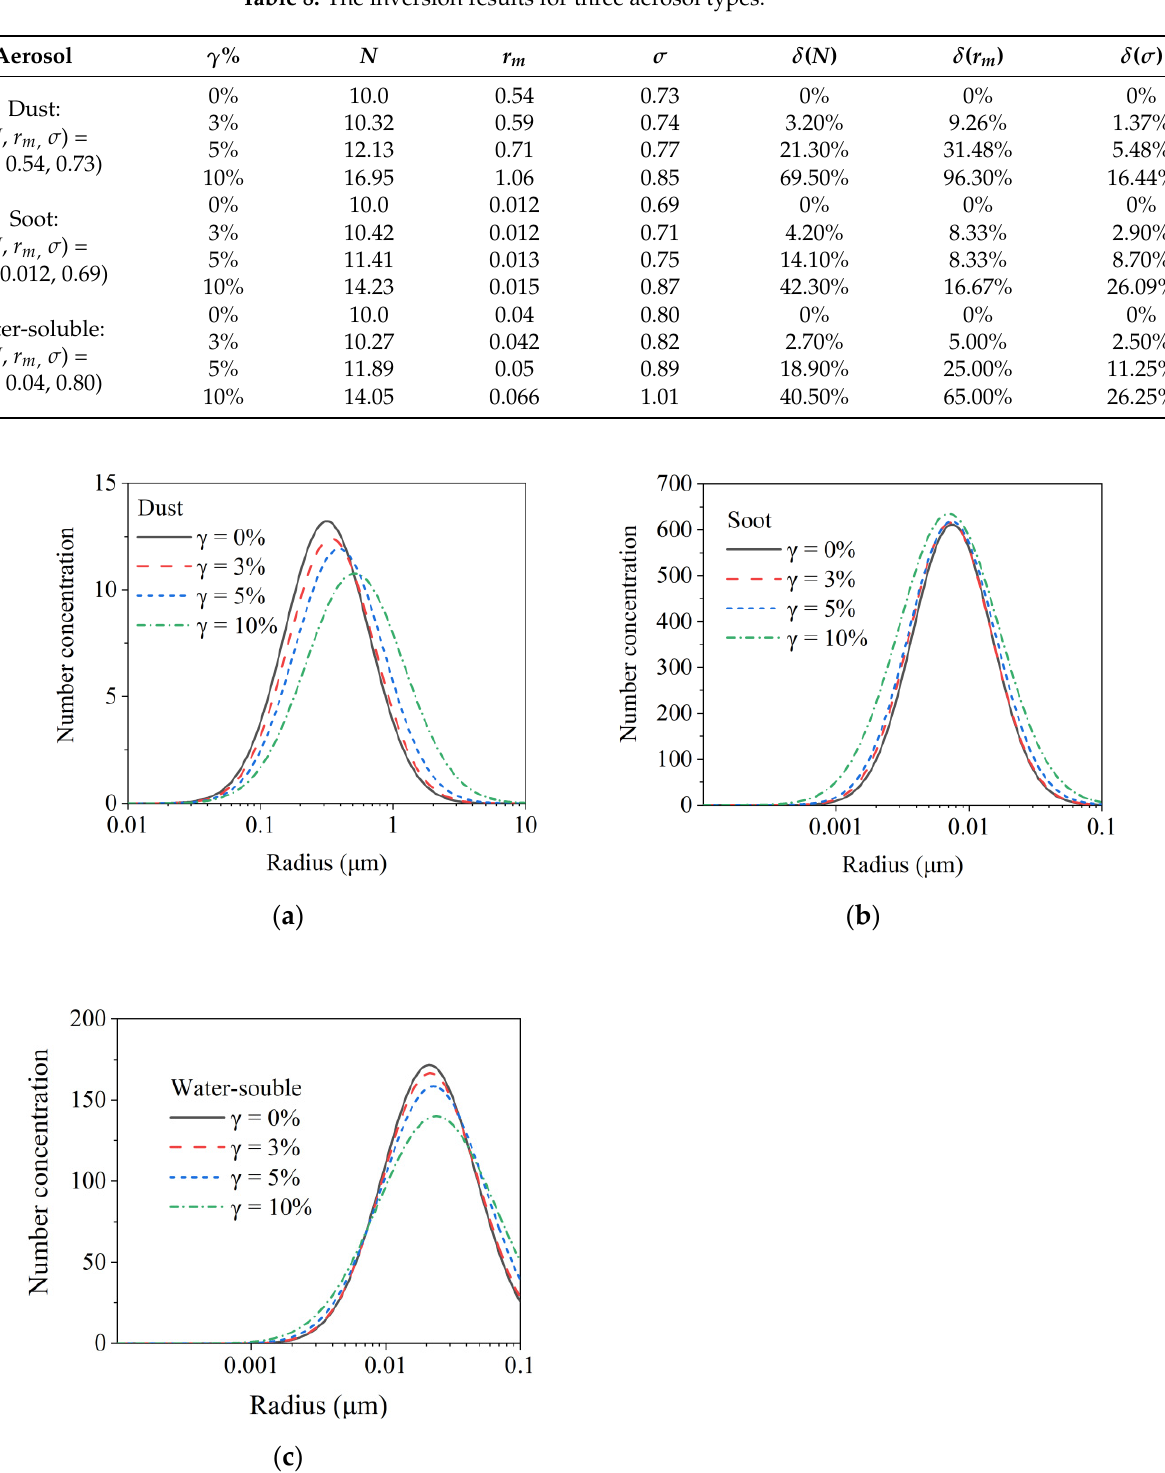
Figure 9. The PSD characteristics of the three aerosol types: ( a ) dust; ( b ) soot; ( c ) water-souble.